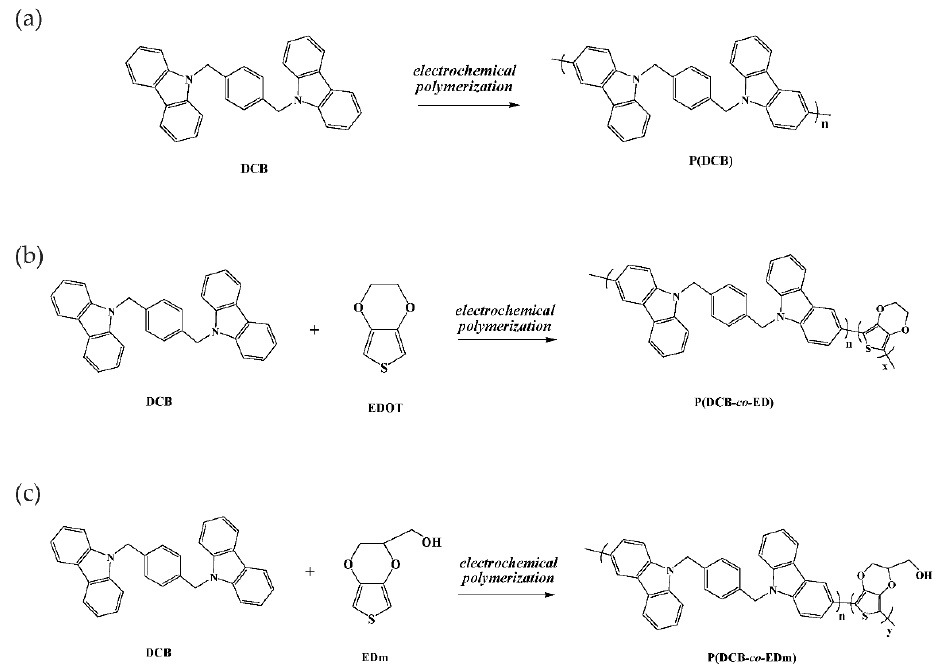
Figure 3. Electrochemical polymerizations of ( a ) P(DCB), ( b ) P(DCB- co -ED), and ( c ) P(DCB- co -EDm).